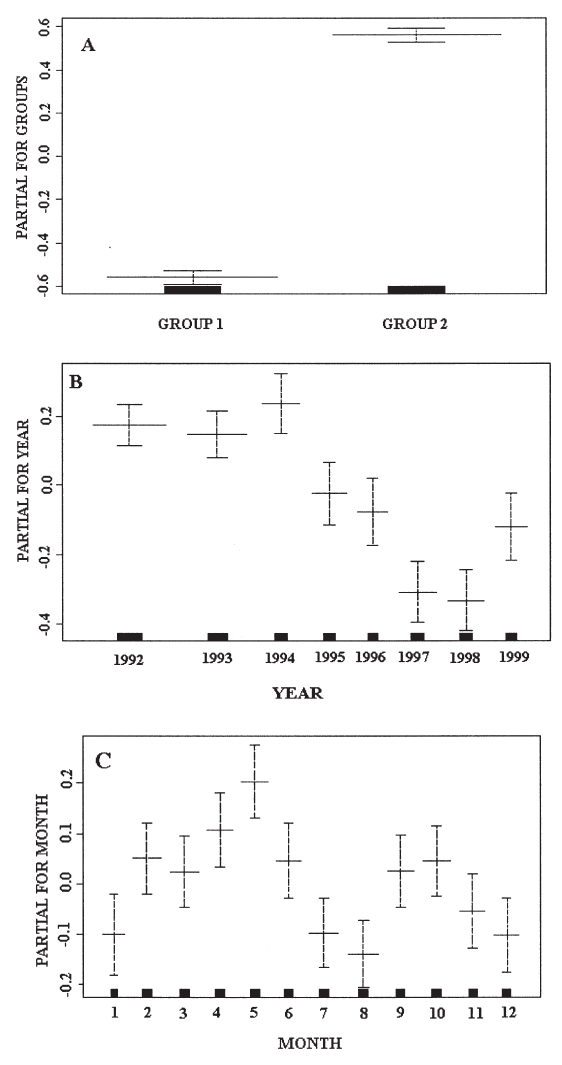
F IG . 7. – Results of Main Effects Model. Each plot represents the contribution of the corresponding variable to the fitted linear predic- tor for Vessel Groups (A), year (B) and month (C). The fitted values are adjusted to average zero and the dashed bars indicate S.D. The width of the solid bars at the base of the plots is proportional to the number of observations at each level of the